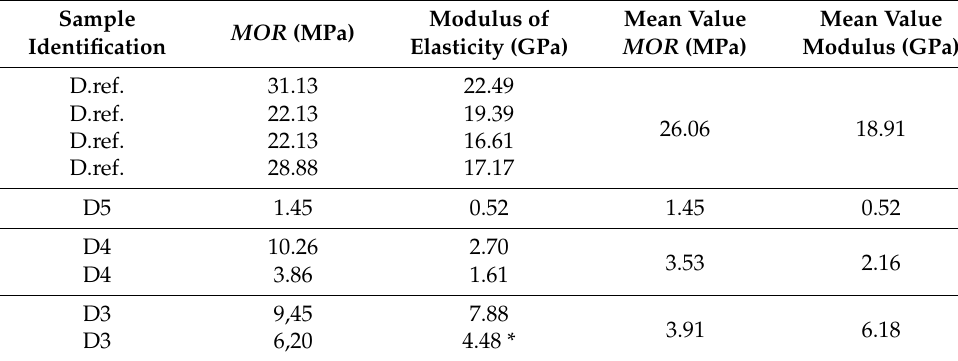
Table 1. MOR and modulus of elasticity for individual samples.